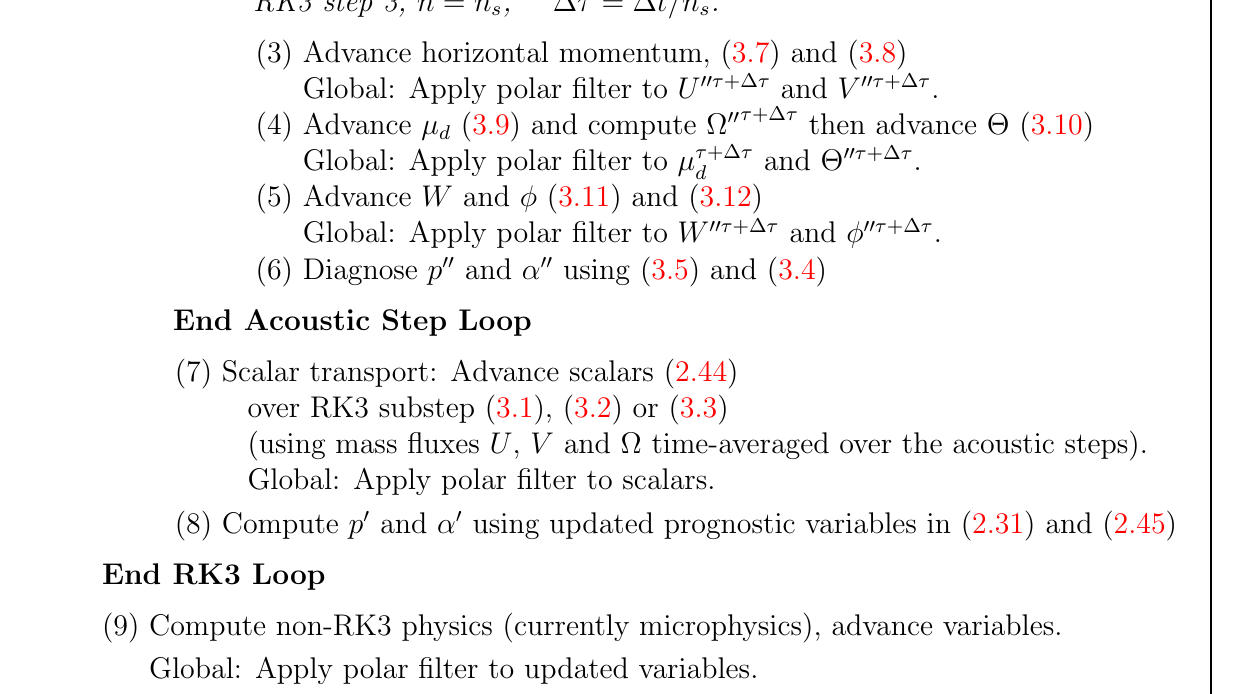
Figure 3.1: Time step integration sequence. Here n represents the number of acoustic time steps for a given substep of the RK3 integration, and n the acoustic time step for the second and third RK3